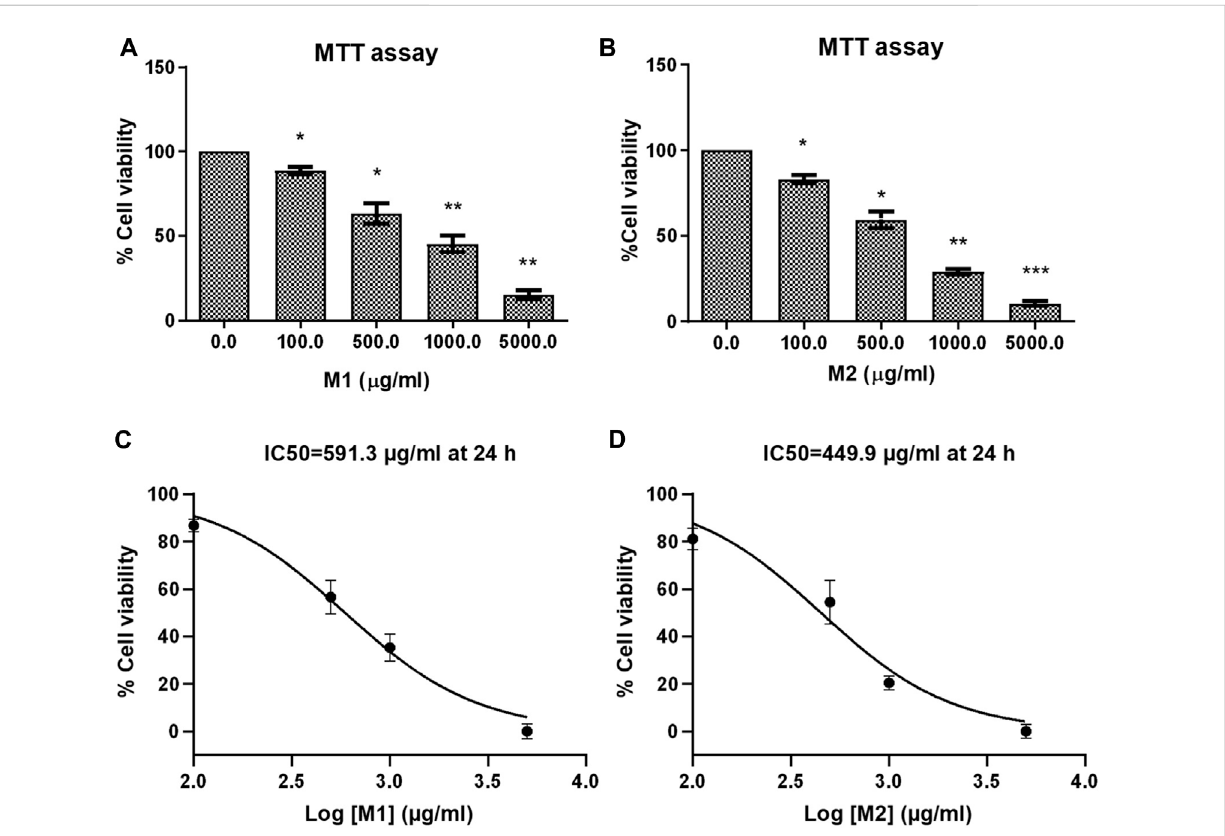
FIGURE 2 Effect of date extracts M1 and M2 on HCT-116 cells. (A, B) Percent (%) cell viability of HCT-116 cells treated with different doses of M1 and M2 (100 – 5,000 μ g/mL) for 24 h. Theresults shown are themean ±SEM of threeindependentexperiments performed intriplicate (ns > 0.01,* p < 0.01, ** p < 0.001, and *** p < 0.0001 represent signi fi cant differences compared with control). (C, D) Graph showing IC 50 of M1 and M2 against HCT-116 colon cancer cell at 24